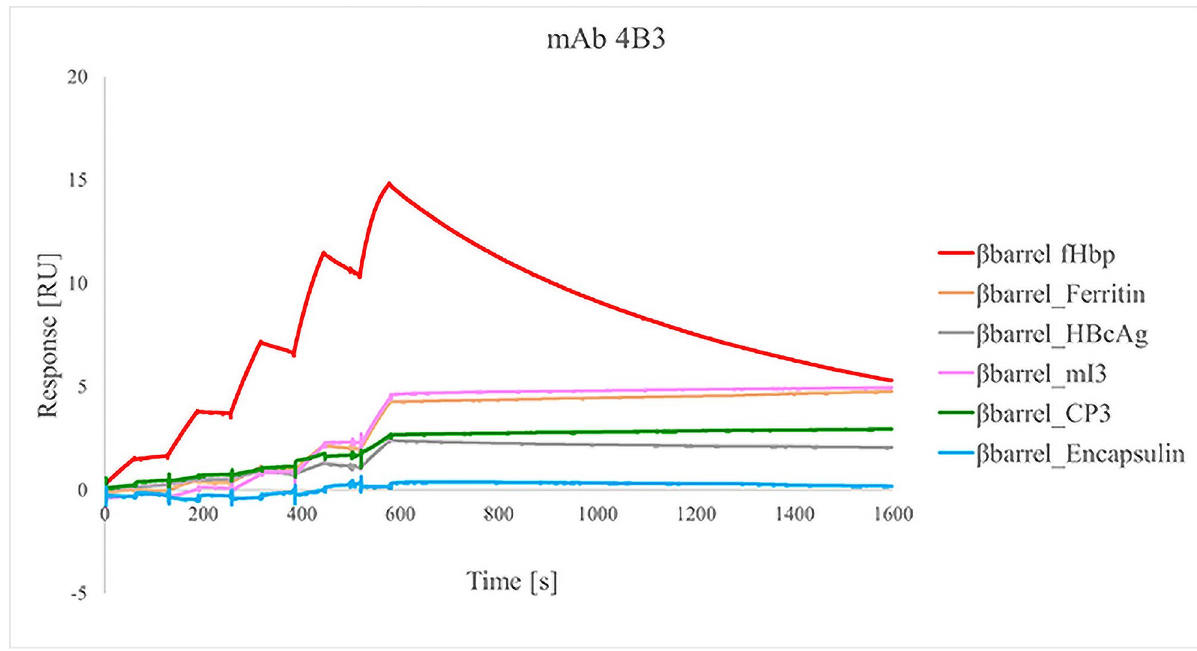
Fig 5. Biacore SPR analysis of monomeric β barrel and β barrel-NPs for evaluation of binding avidity with cross-bactericidal 4B3 hmAb. The interaction between the sample and the antibody has been observed during a time frame of 1500s.